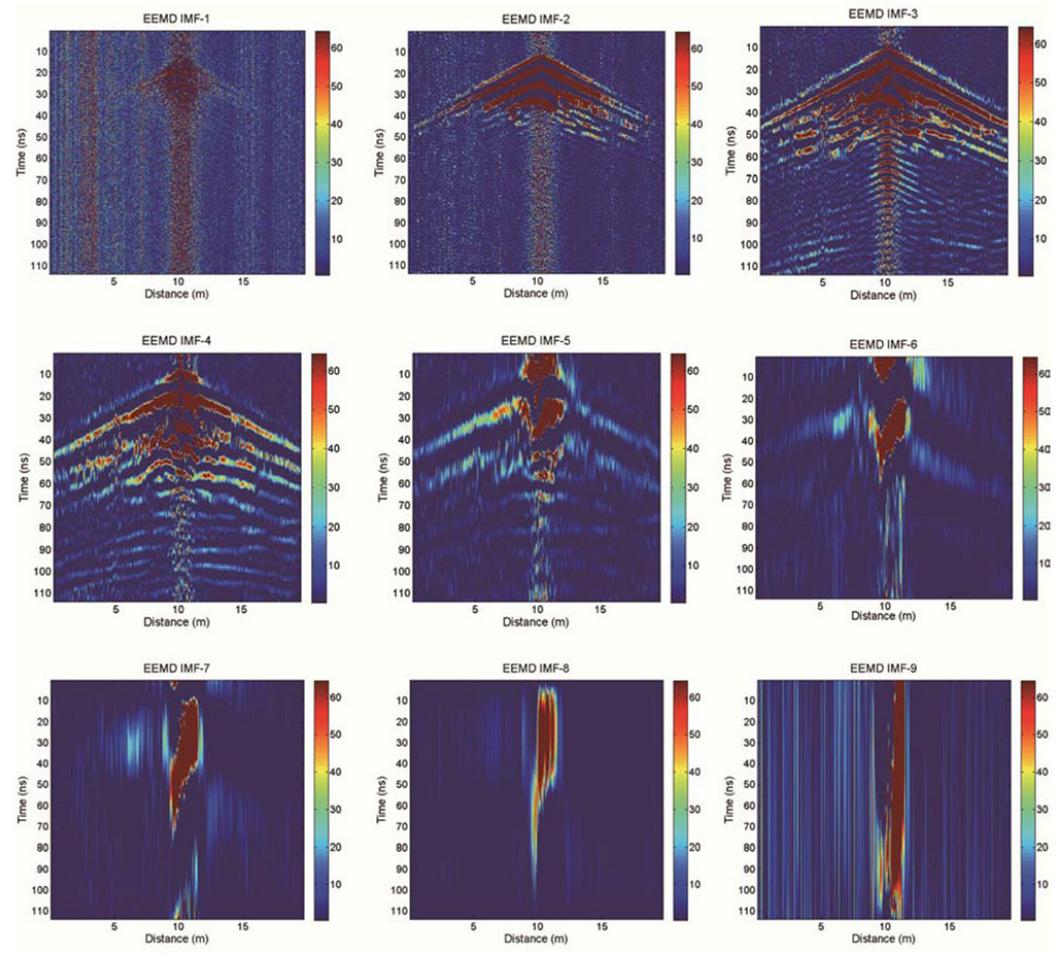
Fig. 11. Filter bank of the original GPR shot gather